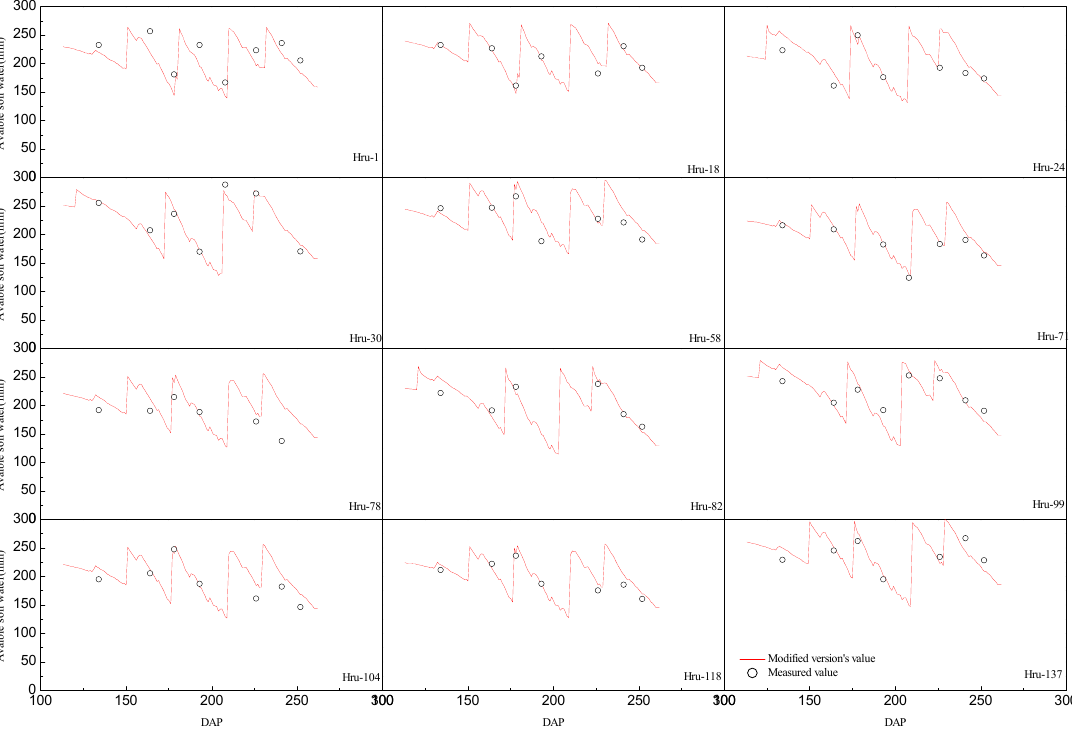
Figure 12. Simulated and measured available soil water.